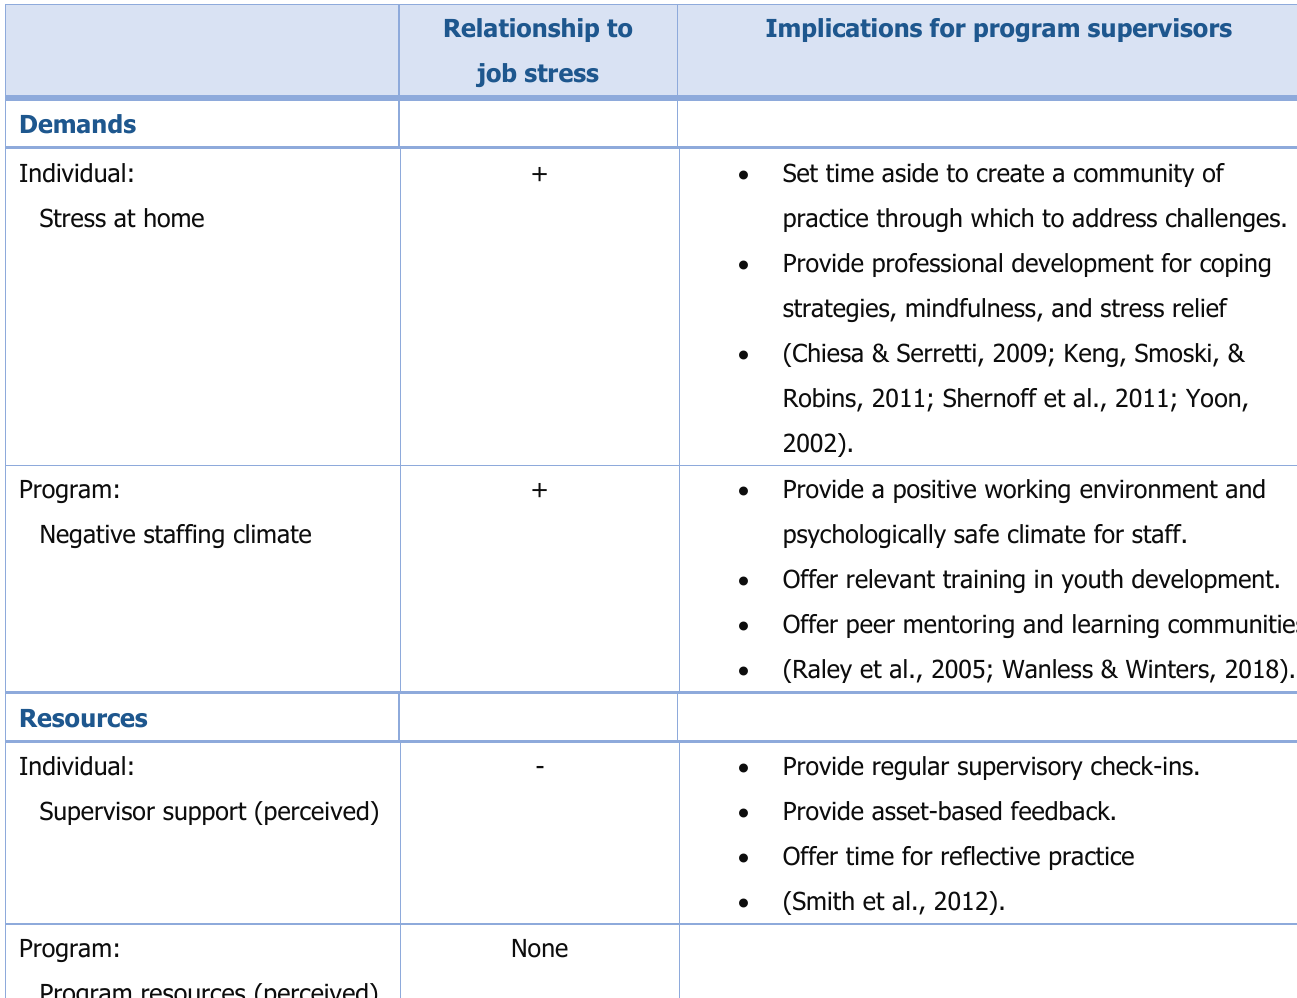
Table 2. Summary of Findings and